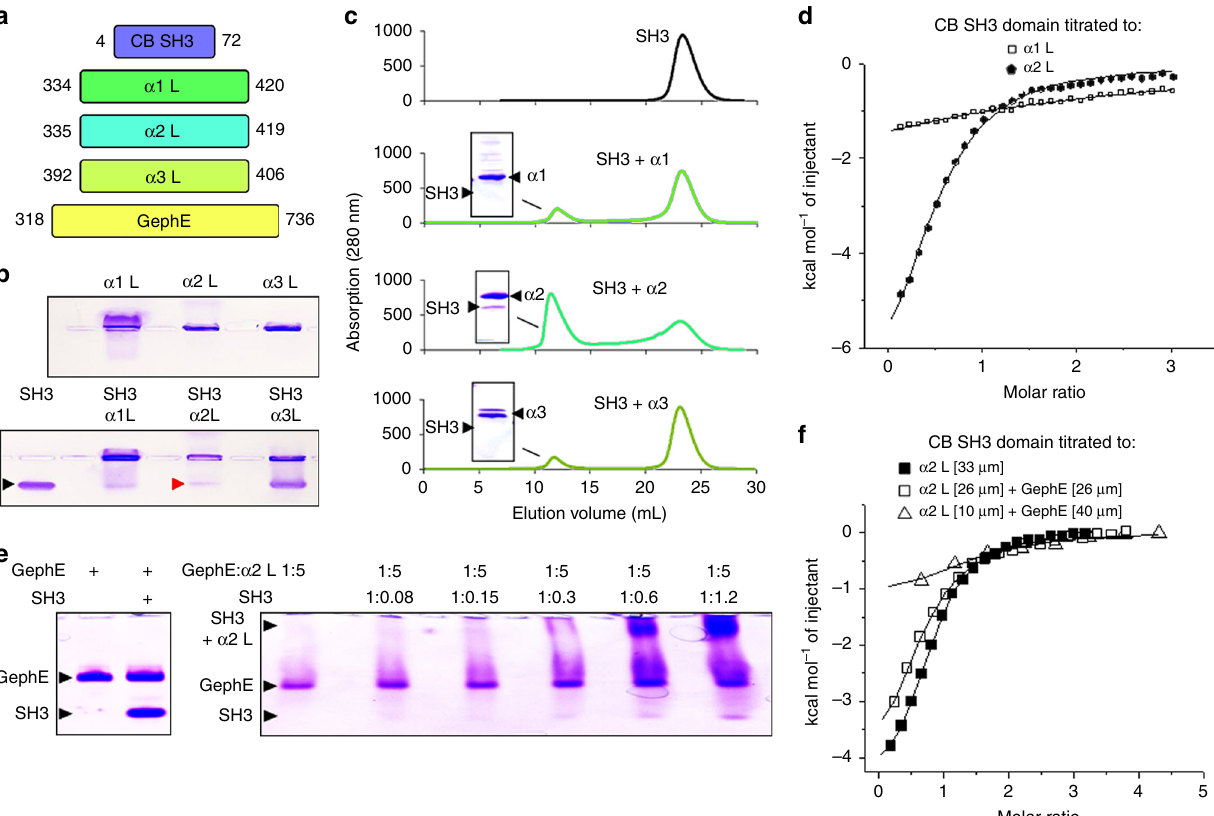
Fig. 1 Analyzing the interaction of GABA A R α subunits with collybistin. a Cartoon showing the puri fi ed proteins used for biochemical studies of α -subunit interaction with gephyrin and CB. b Receptor subunits were subject to NAGE (pockets mark sites of protein application) followed by coomassie staining, revealing that α -subunit loops slowly migrate to the cathode. CB-SH3 alone or mixed with a threefold excess of GABA A R intracellular domains reveals that α 2L markedly alters the migration of SH3 (red arrow). c SEC analysis was used to explore the behavior of CB-SH3 alone or when mixed with equimolar amounts of α 1L, α 2L, or α 3L. Fusion proteins were detected in eluates using absorbance at 280 nM and coomassie staining after SDS-PAGE (insets), verifying the presence of the SH3 domain at lower elution volumes in the fraction containing α 2L. d CB-SH3 was titrated against α 1L and α 2L. The measured binding enthalpies are plotted as a function of the molar ratio of the SH3 domain to the GABA A R α 1 and α 2 loops. e GephE and GephE + CB-SH3 were subject to NAGE. The migration of the respective proteins is indicated. In presence of the SH3 domain the migration of gephyrin is not altered indicating that the proteins do not interact on NAGE (left panel). GephE in the presence of a fi vefold molar excess of α 2L is partly retained in the pocket and partly migrates towards the anode (lane 1 right panel). Addition of increasing amounts of the SH3 domain to the GephE- α 2L complex allows more gephyrin to enter the gel and migrate towards the anode. At the same time SH3 binding to α 2L retains SH3 in the pocket. This indicates that SH3 and gephyrin compete for α 2 binding. f CB-SH3 was titrated against α 2L alone or in combination with GephE, and the measured binding enthalpies are plotted